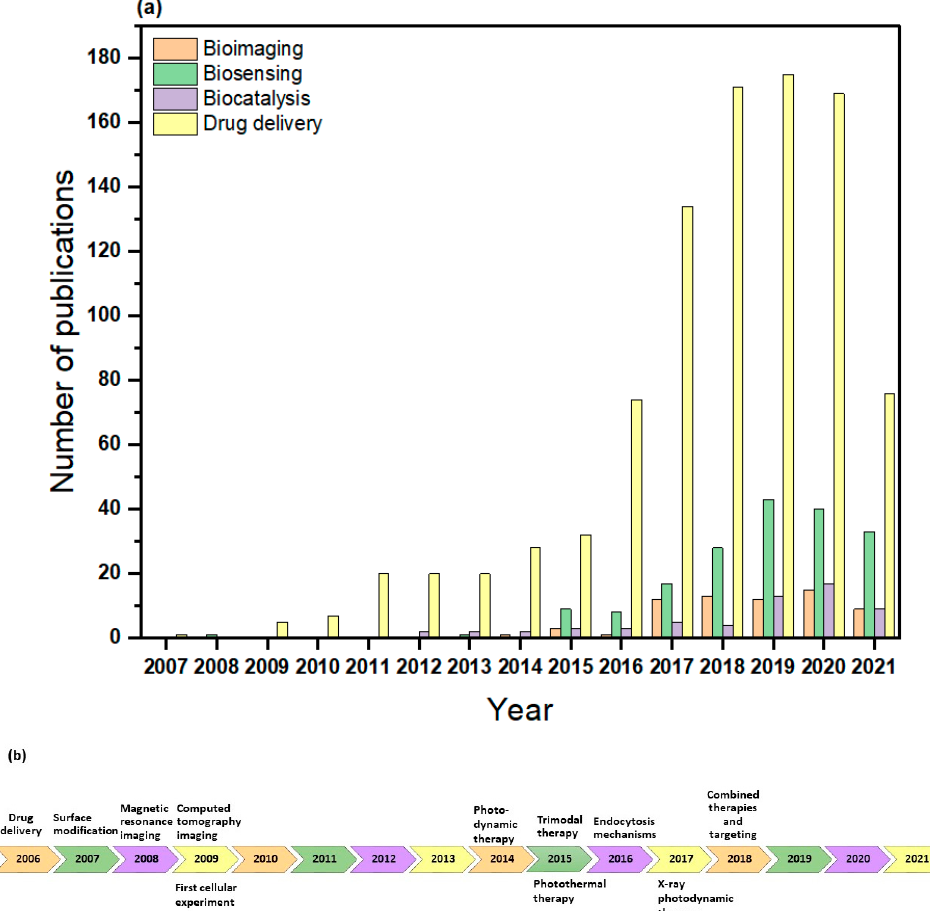
Figure 8. ( a ) The number of publications featuring the terms “metal − organic framework” and “bi- oimaging,” “biosensing,” “biocatalysis”, and “drug delivery” in their topic. Retrieved from the Web of Science on 11 July 2021. ( b ) Major milestones in the biomedical applications of MOFs [126]. Table 2. Biomedical applications of MOFs with